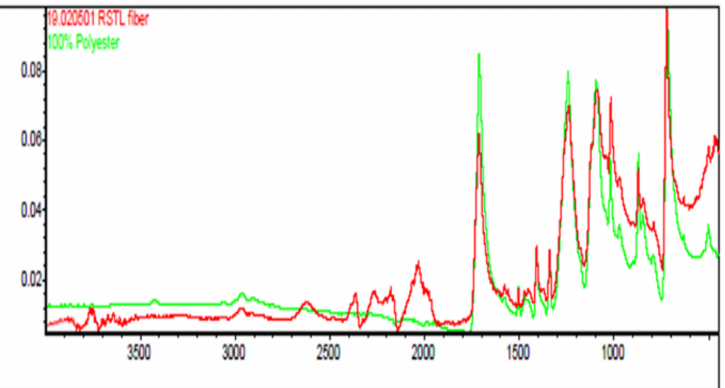
Figure A3. FTIR Analysis shows that the fibers are 100% polyester. Peaks left of 2000 wave numbers are from